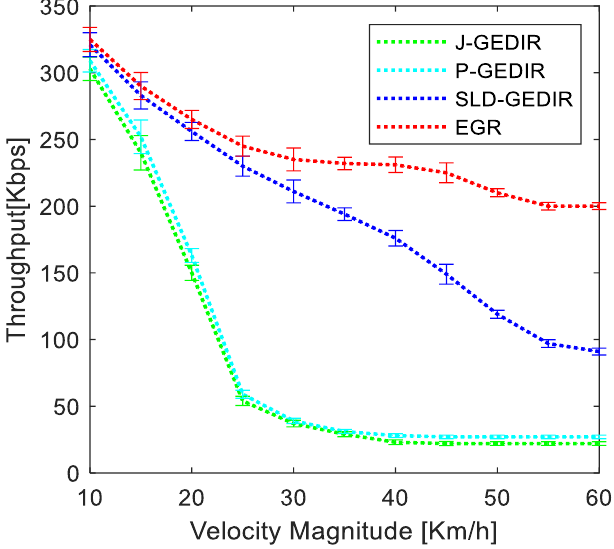
Figure 12. Effect of velocity on throughput.